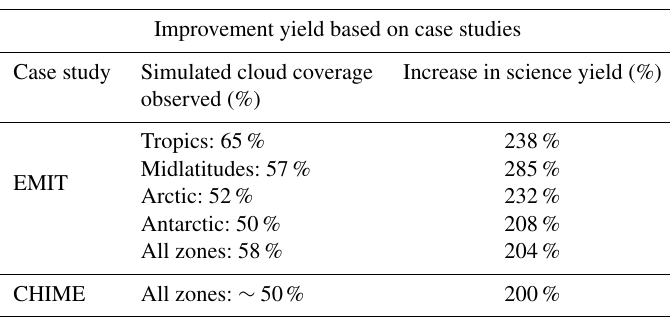
Table 6. A case study of EMIT (Earth Surface Mineral Dust Source Investigation) concerning a global cloud fraction simulation was used to determine the improvement yield of the cloud-screening tool in terms of